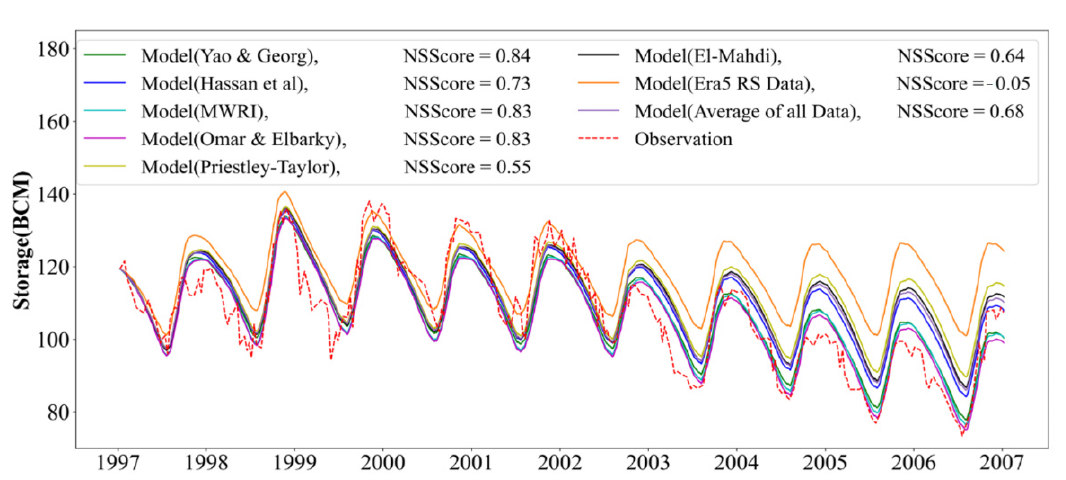
Figure 9. Simulated lake storage using different evaporation estimations.